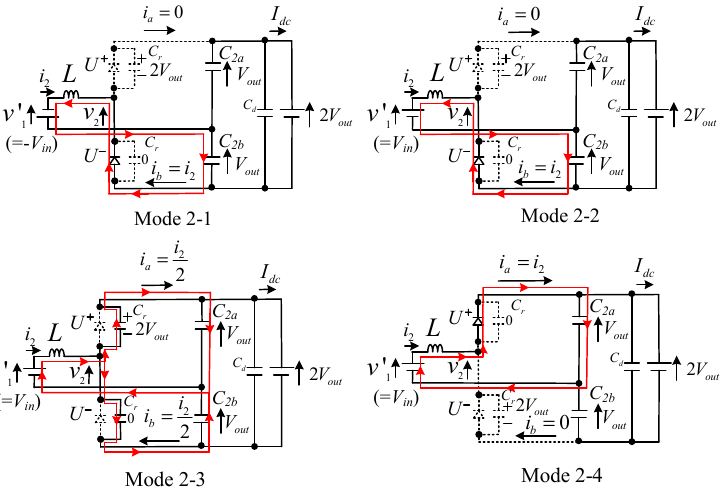
Figure 6. Commutations of the secondary diode rectifier circuit.